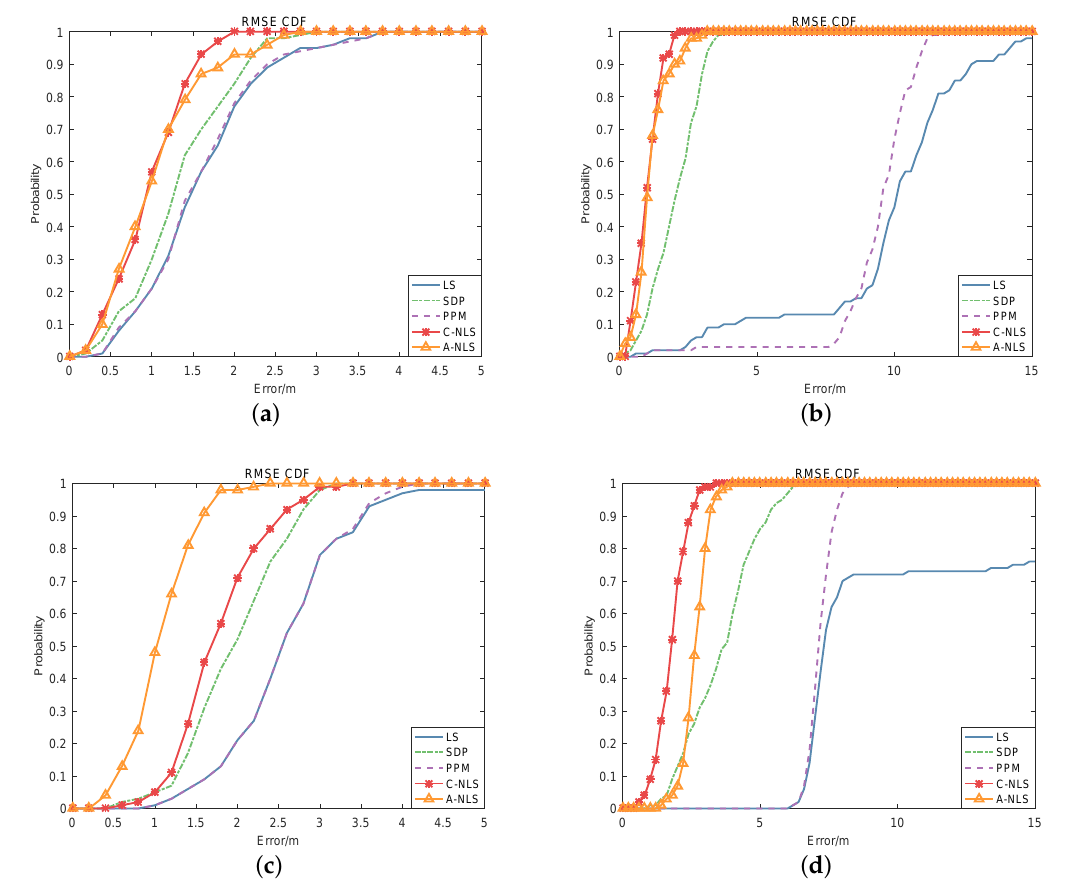
Figure 5. The CDF of the minimum mean squared error (MESE) for algorithms in the different scenarios and environments. Above, Graphs ( a , b ) are the results in the noncooperative scenario, where (a) represents the LOS environment, while (b) represents the NLOS environment. Graphs ( c , d ) are the results in the cooperative scenario, which represent the LOS and NLOS environments,